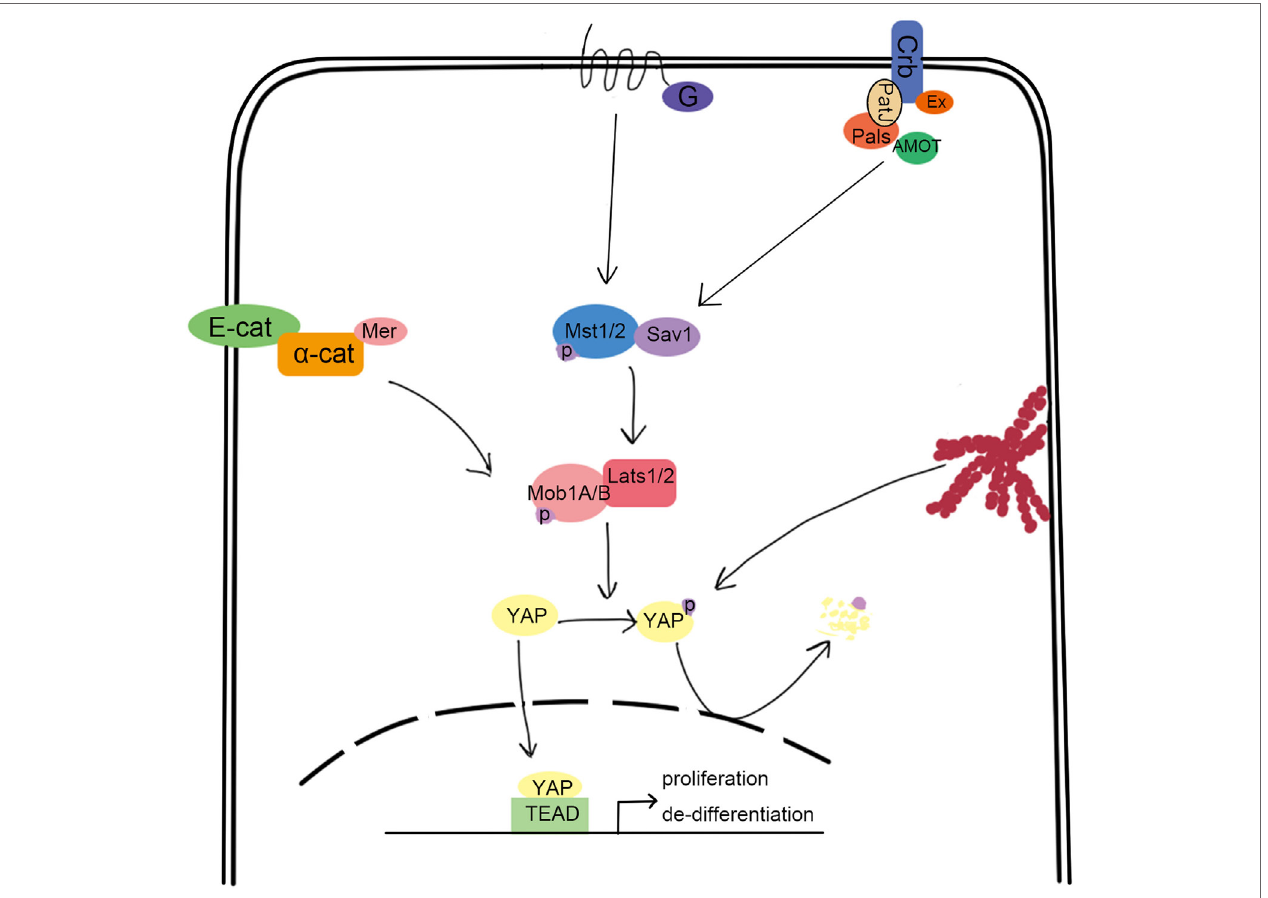
FiGURe 1 | Overview of the canonical hippo signaling pathway. Signals such as mechanical stress, and GPCR can activate Mst1/2, bound with Sav1 through the SARAH domain. The activated Mst1/2 kinases phosphorylate and activate Lats1/2, which can interact with YAP through their respective PPxY and WW domains. Lats1/2 then phosphorylate YAP, which traps it in the cytoplasm upon binding to 14-3-3. This results in the loss of YAP function, which is involved in promoting the transcription of cell proliferation-related